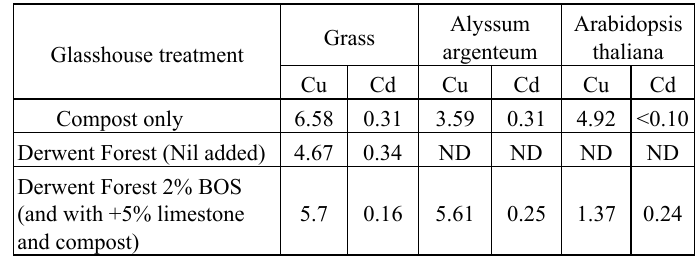
Refer to Fig. 11b for trial plot description Fig. 13. Carbon/Nitrogen ratios for Derwent Forest Table 2. Copper and cadmium levels in grass